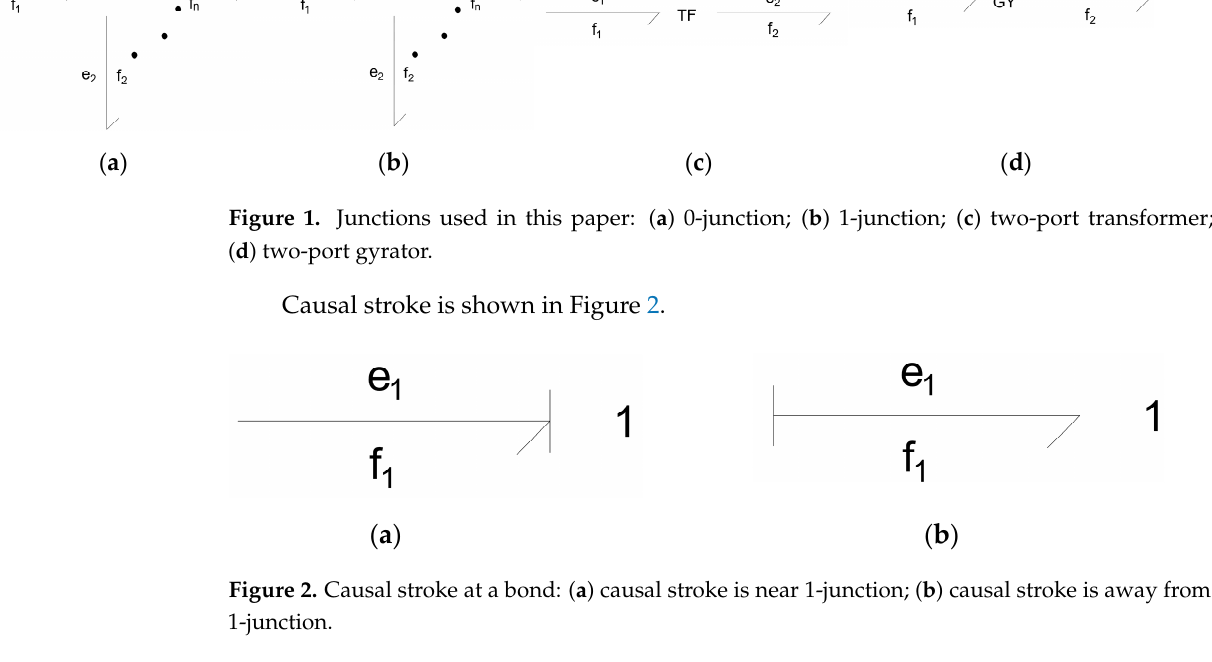
Figure 2. Causal stroke at a bond. (a) The causal stroke is near 1-junction. (b) The causal stroke is 106 away from 1-jection. 107